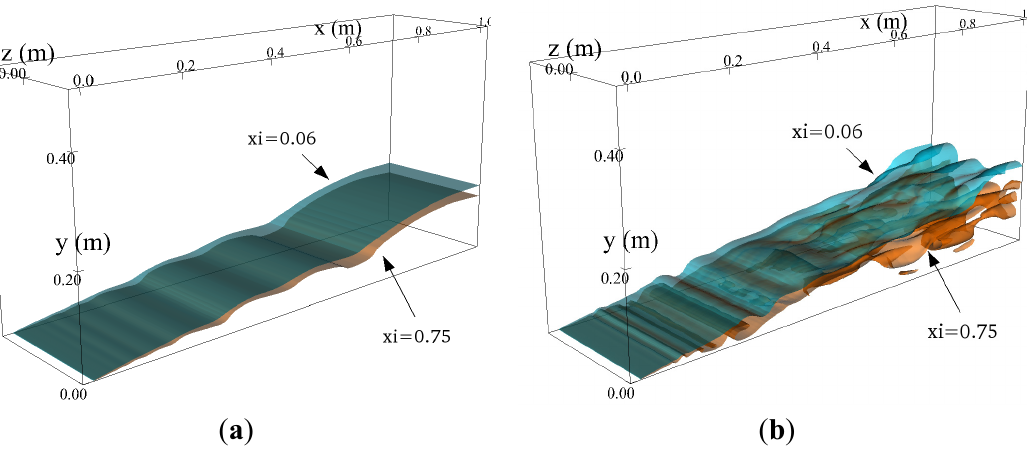
Figure 16. Iso-surfaces of mixture fractions. ( a ) t = 0 s; ( b ) t = 0.536